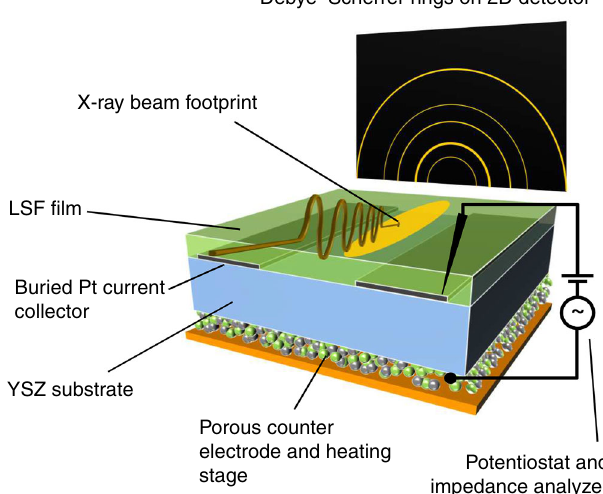
Fig. 1 Sketch of the experimental setup for simultaneous electrochemical and X-ray diffraction measurements at elevated temperatures. The sample — consisting of Y-stabilised zirconia electrolyte (blue), buried Pt current collector (gray), La 0.6 Sr 0.4 FeO 3- δ thin fi lm working electrode (green), and porous Pt/La 0.6 Sr 0.4 FeO 3- δ counter electrode (green and gray particles at the bottom side) — is placed onto the heating stage (orange) within the experimental chamber (not shown for the sake of simplicity). The X-ray beam (symbolised by the brownish wave) hits the working electrode with a very fl at angle of incidence. The diffracted X-rays are recorded as Debye – Scherrer rings on a 2D detector (outside the chamber), which is placed in a certain distance to the